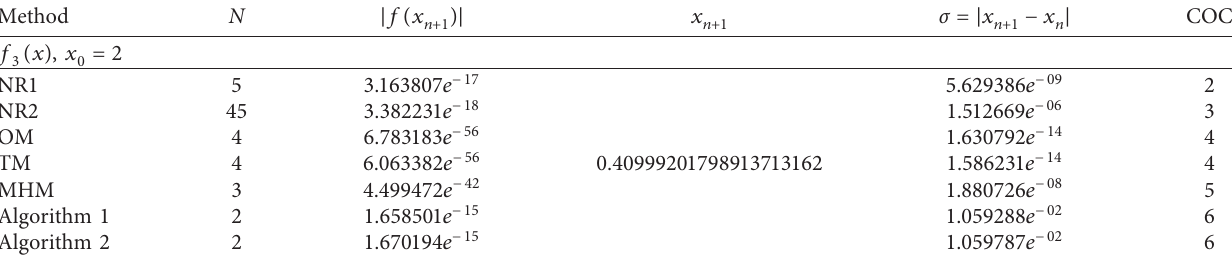
Table 3: Comparison of various iterative methods.